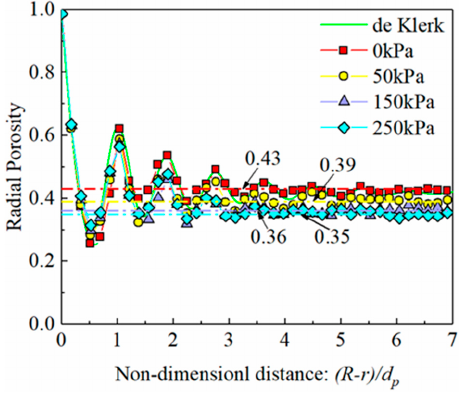
Figure 6. Radial porosity distribution under different vertical